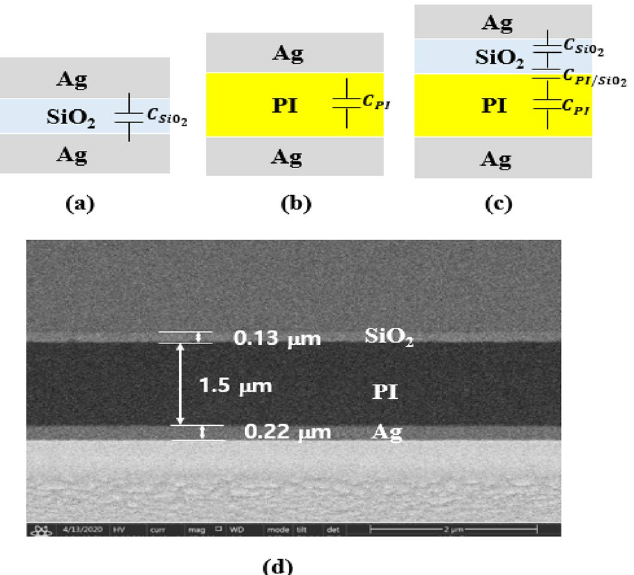
Figure 4. Schematics of the vertical structure for the MIM capacitors and SEM image; ( a ) Ag/SiO 2 /Ag, ( b ) Ag/ PI/Ag, ( c ) Ag/SiO 2 /PI/Ag and ( d ) the cross-sectional analysis of the MIM capacitor shown in ( c